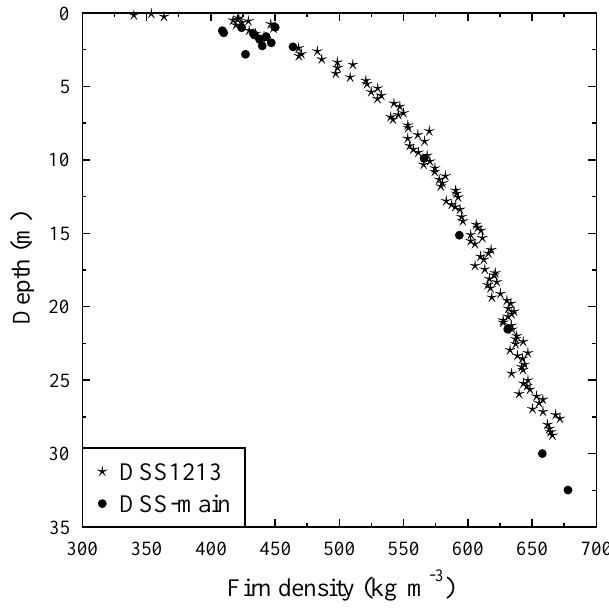
Figure 2. Firn density from the DSS-main and DSS1213 ice cores as a function of physical